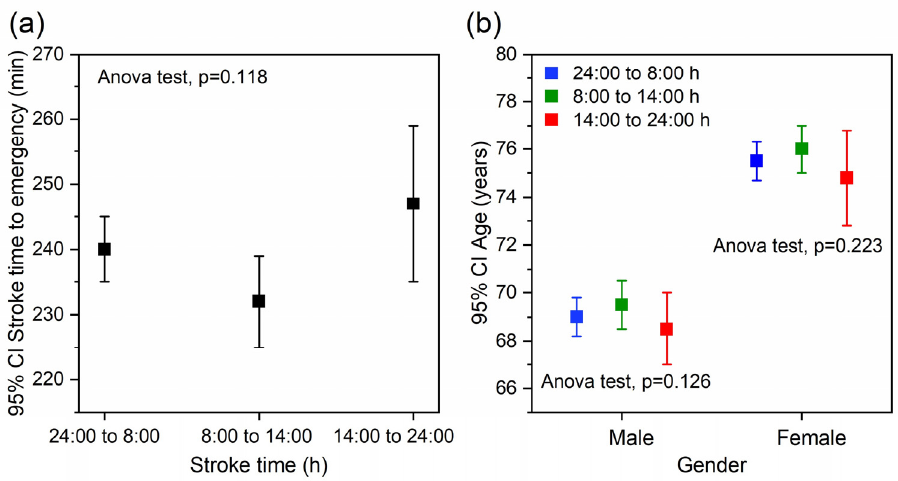
Figure 2. Relationship between stroke time and ( a ) time to emergency care and ( b ) age with respect to gender.